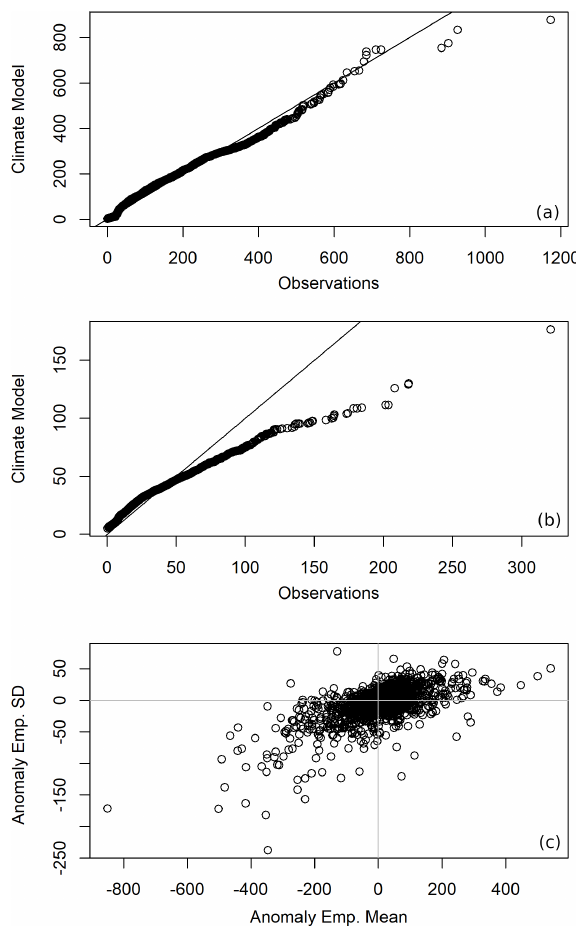
Figure 2. Quantile–quantile (Q–Q) plots comparing the empirical mean values (a) and the empirical standard deviations (b) of the annually maximised monthly precipitation of the CRU TS4.04 re- analysis data set and the AWI-ESM model data set. The deviance of the empirical mean and standard deviation are plotted against each other in (c) . Values are given in millimetres per month.